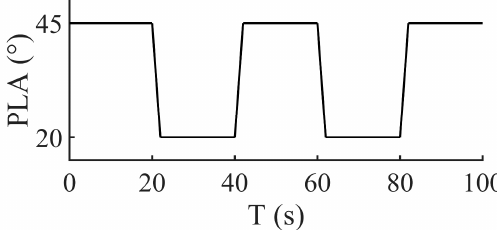
Figure 13. The variation of PLA in the simulation.